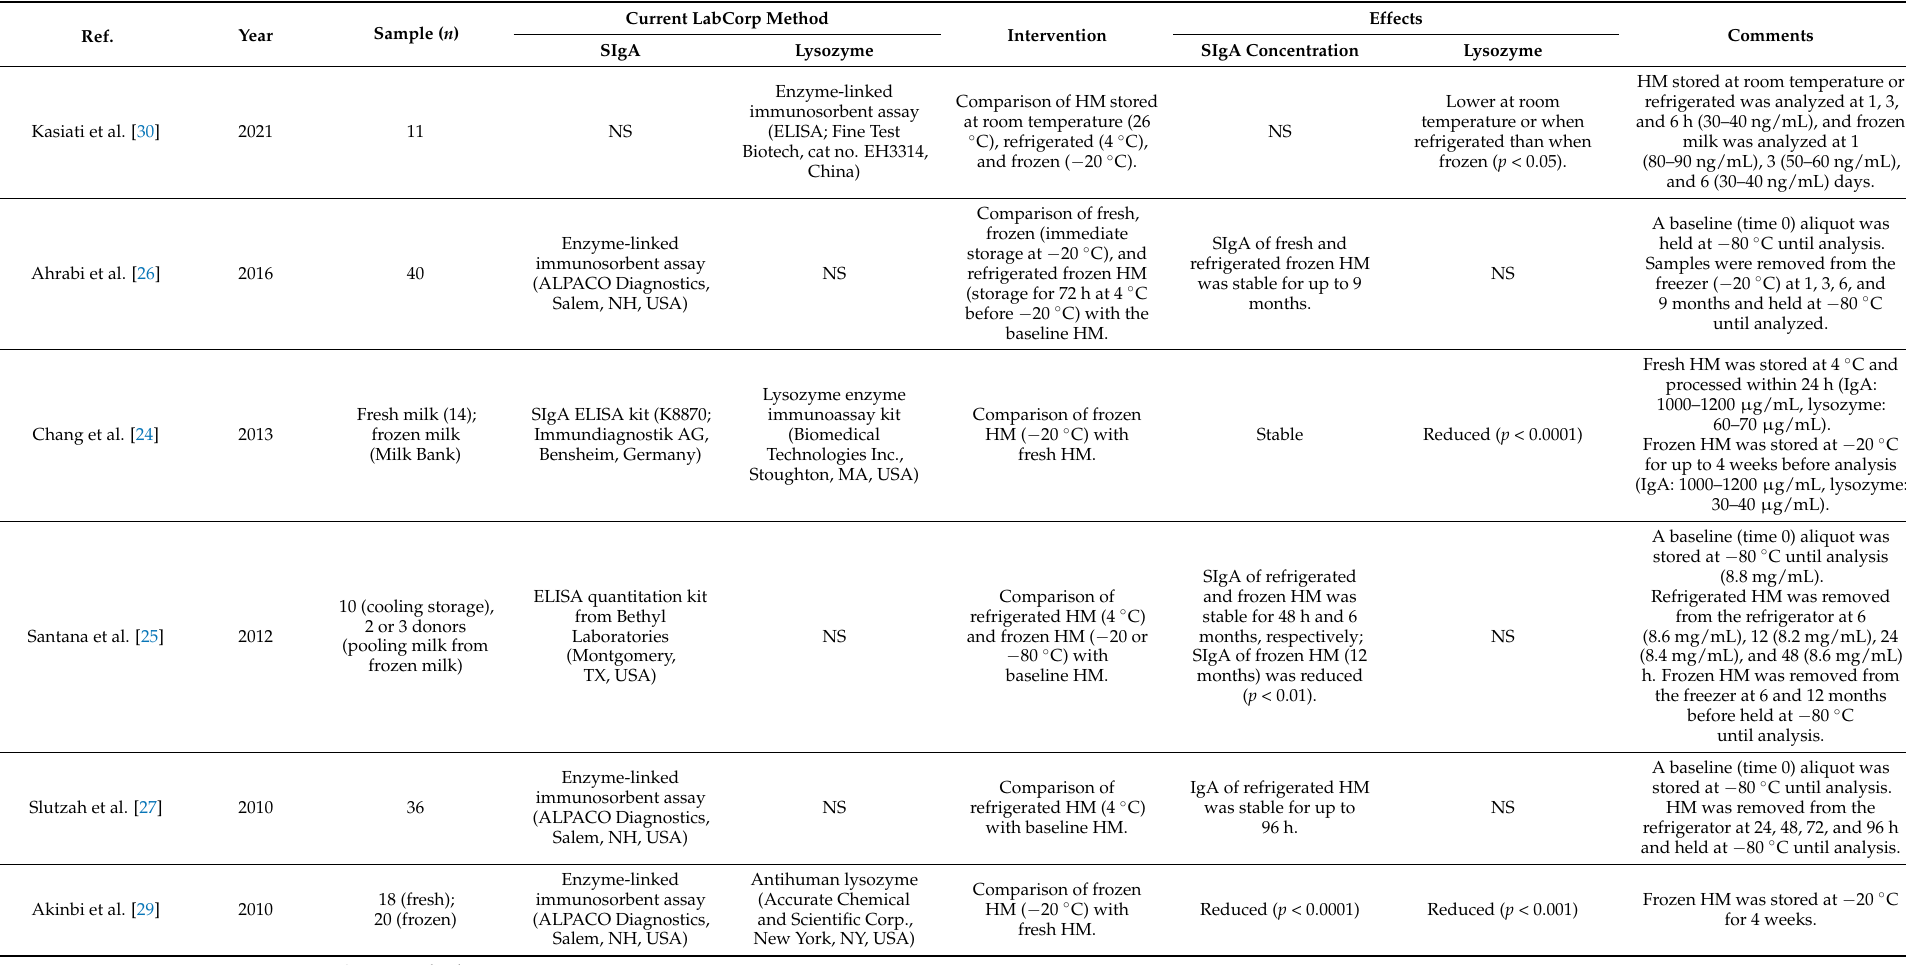
Table 5. Overview of studies investigating the effects of storage conditions on SIgA concentration and lysozyme activity.